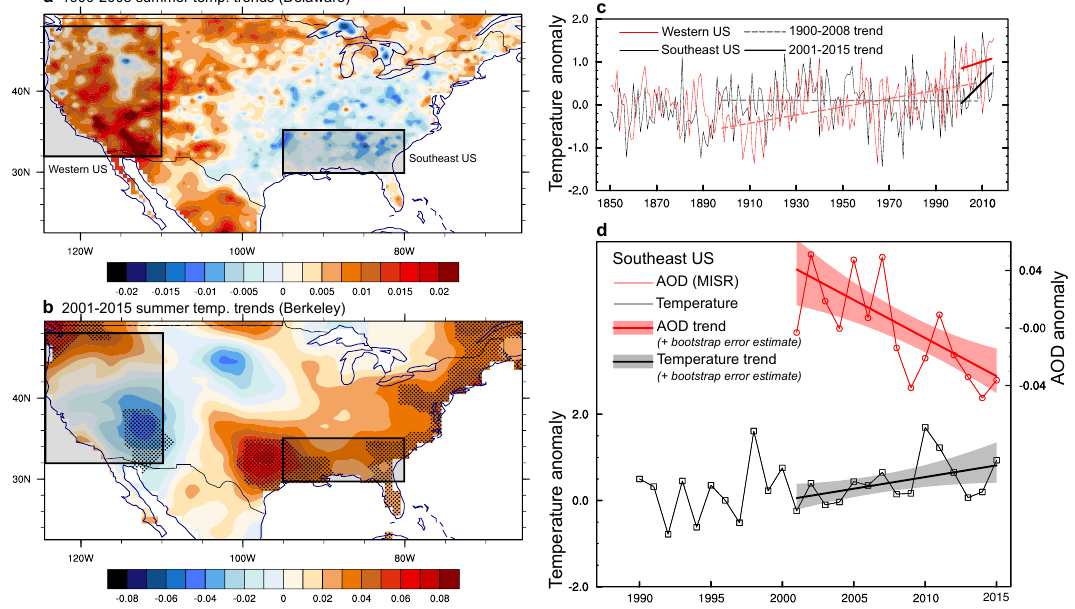
Figure 2. ( a ) linear trends in summer (May–September) surface temperatures from the Delaware dataset for 1900–2008 (0.5 degree resolution); ( b ) linear trends in summer surface temperatures from the Berkeley dataset for 2001–2015 (one-degree resolution). Stipling indicates statistically significant trends at 95% confidence; ( c ) regionally averaged summer surface temperature anomalies for 1850–2015 for the Southeast US (black) and the Western US (red) (regions defined by boxes in ( a , b )). Linear trends for 1900–2008 (dashed lines) and 2001–2015 (solid lines) are noted; ( d ) summertime surface temperature and aerosol optical depth (AOD) anomalies for the southeast US for 1990–2015. The 2001–2015 linear trend is noted by solid lines. Error estimates calculated using the bootstrapping method ( n = 1000) are shown as shaded